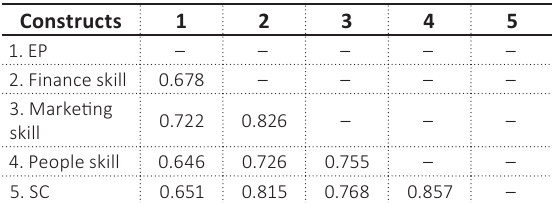
Table 5. Discriminant validity (HTMT) Constructs